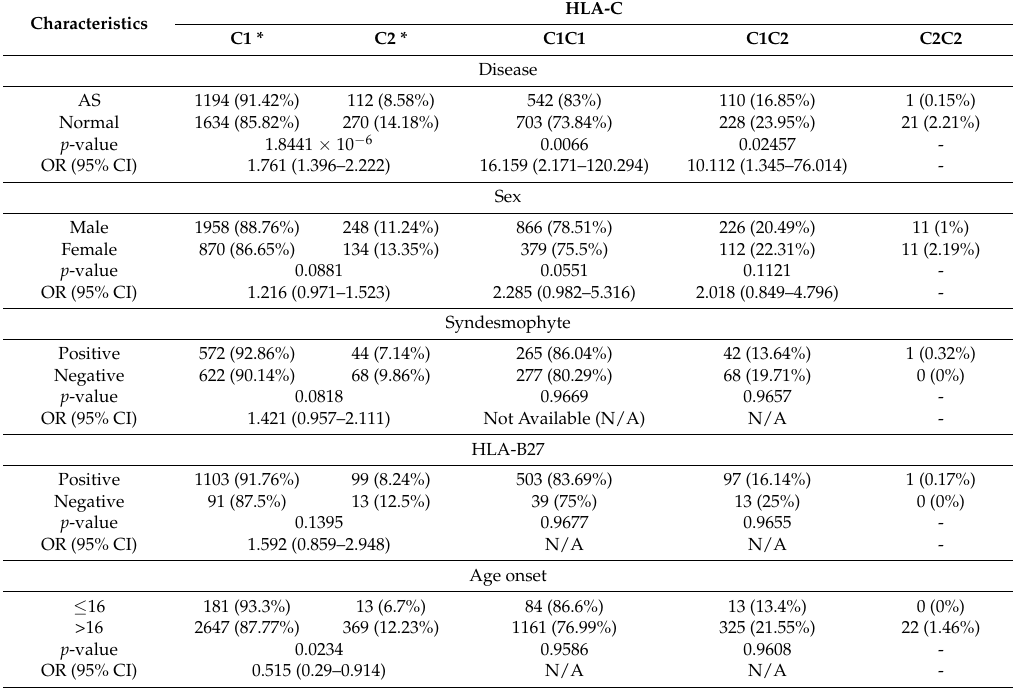
Table 3. Association of the HLA-C1 (asparagine) and C2 (lysine) group with Taiwanese AS susceptibility and clinical